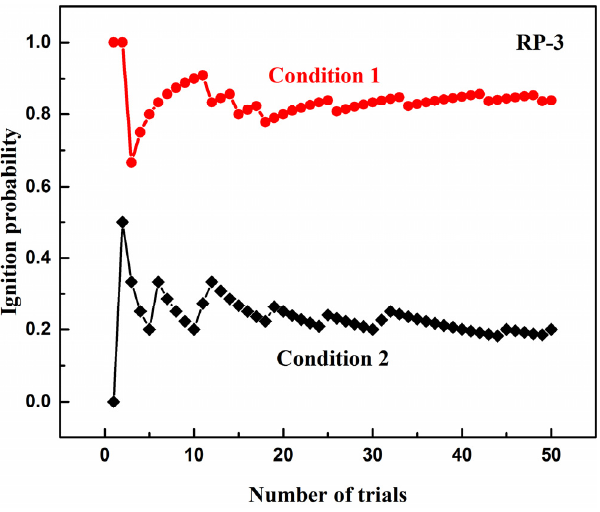
Figure 3. Ignition probability versus number of trails.